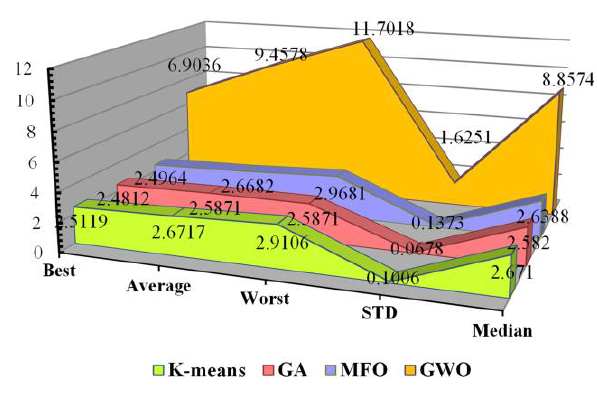
Figure 2. Performance of different techniques